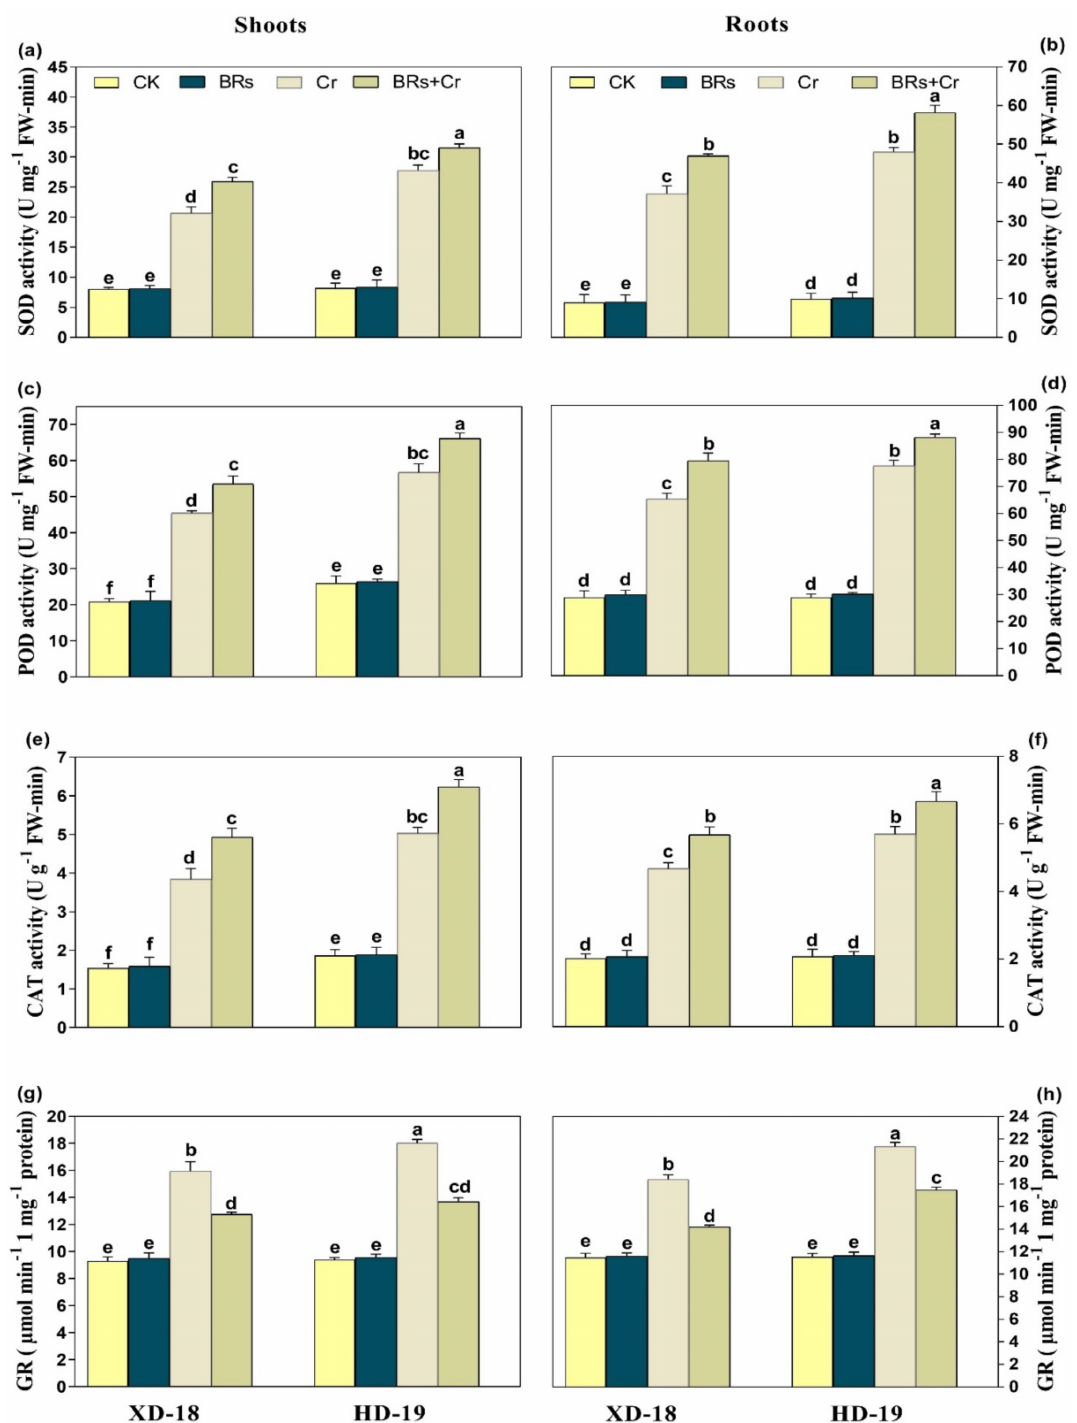
Figure 7. Effects of foliar-applied BRs on the activities of ( a ) superoxide dismutase (SOD) in shoots, ( b ) superoxide dismutase (SOD) in roots, ( c ) peroxidase (POD) in shoots, ( d ) peroxidase (POD) in roots ( e ) catalase (CAT) in shoots, ( f ) catalase (CAT) in roots, ( g ) glutathione (GR) in shoots, and ( f ) glutathione (GR) enzymes in the roots of both soybean genotypes (XD-18 and HD-19) under chromium (Cr) (0, and 100 µ M) stress. Values are the means ± SD of four independent replicates. Different alphabetical letters on bars indicate significant differences among the treatments ( p < 0.05) by the least significant difference